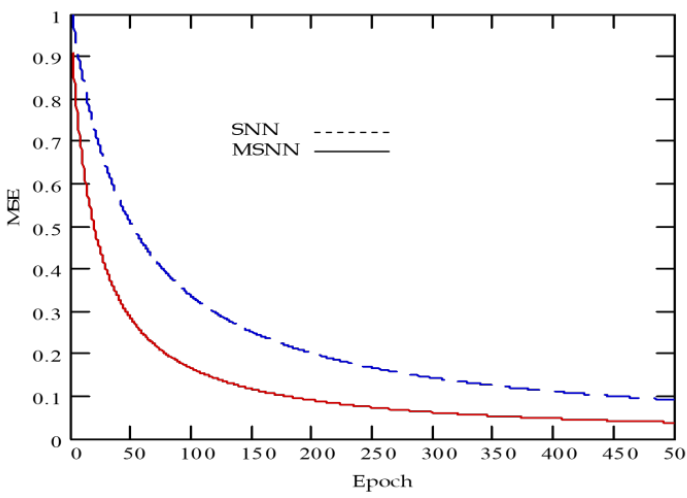
Figure 7. Averaged learning curve comparison between sigmoidal neural network (SNN) and multilevel sigmoidal neural network (MSNN) models.